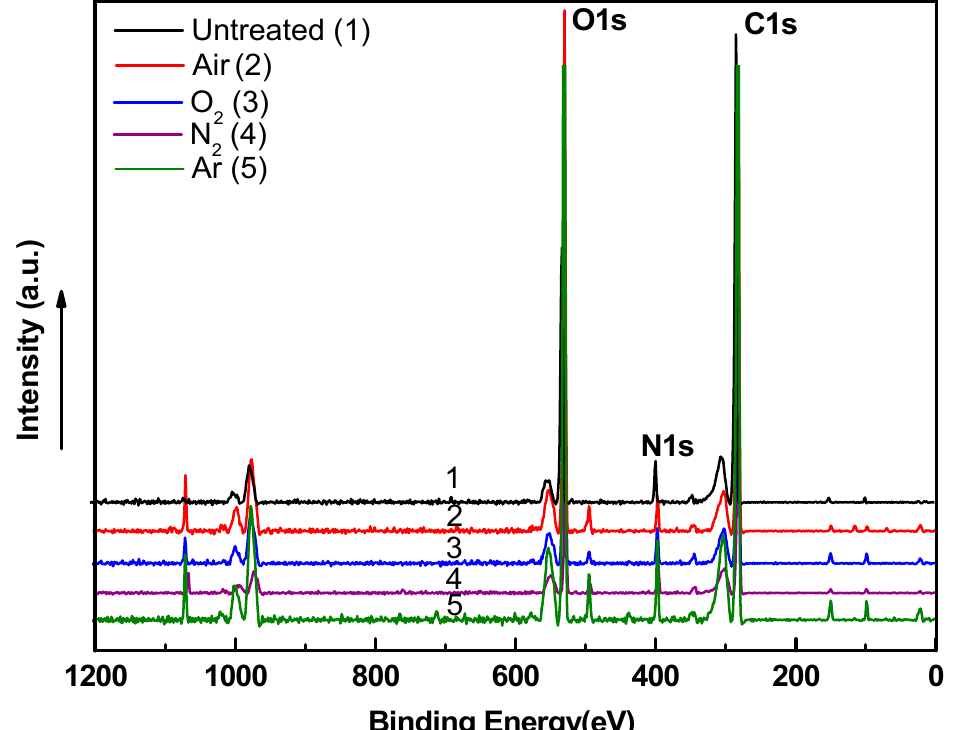
Figure 10. XPS survey spectra of plasma-treated PU using different gases.